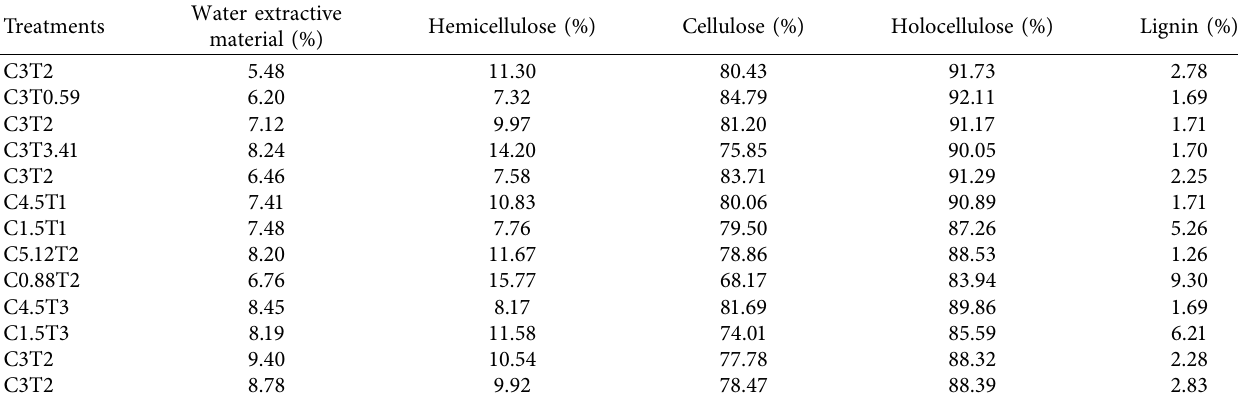
Table 3: Content of water-extractive material, hemicellulose, cellulose, holocellulose, and lignin in OPEFB cellulose. Water Treatments